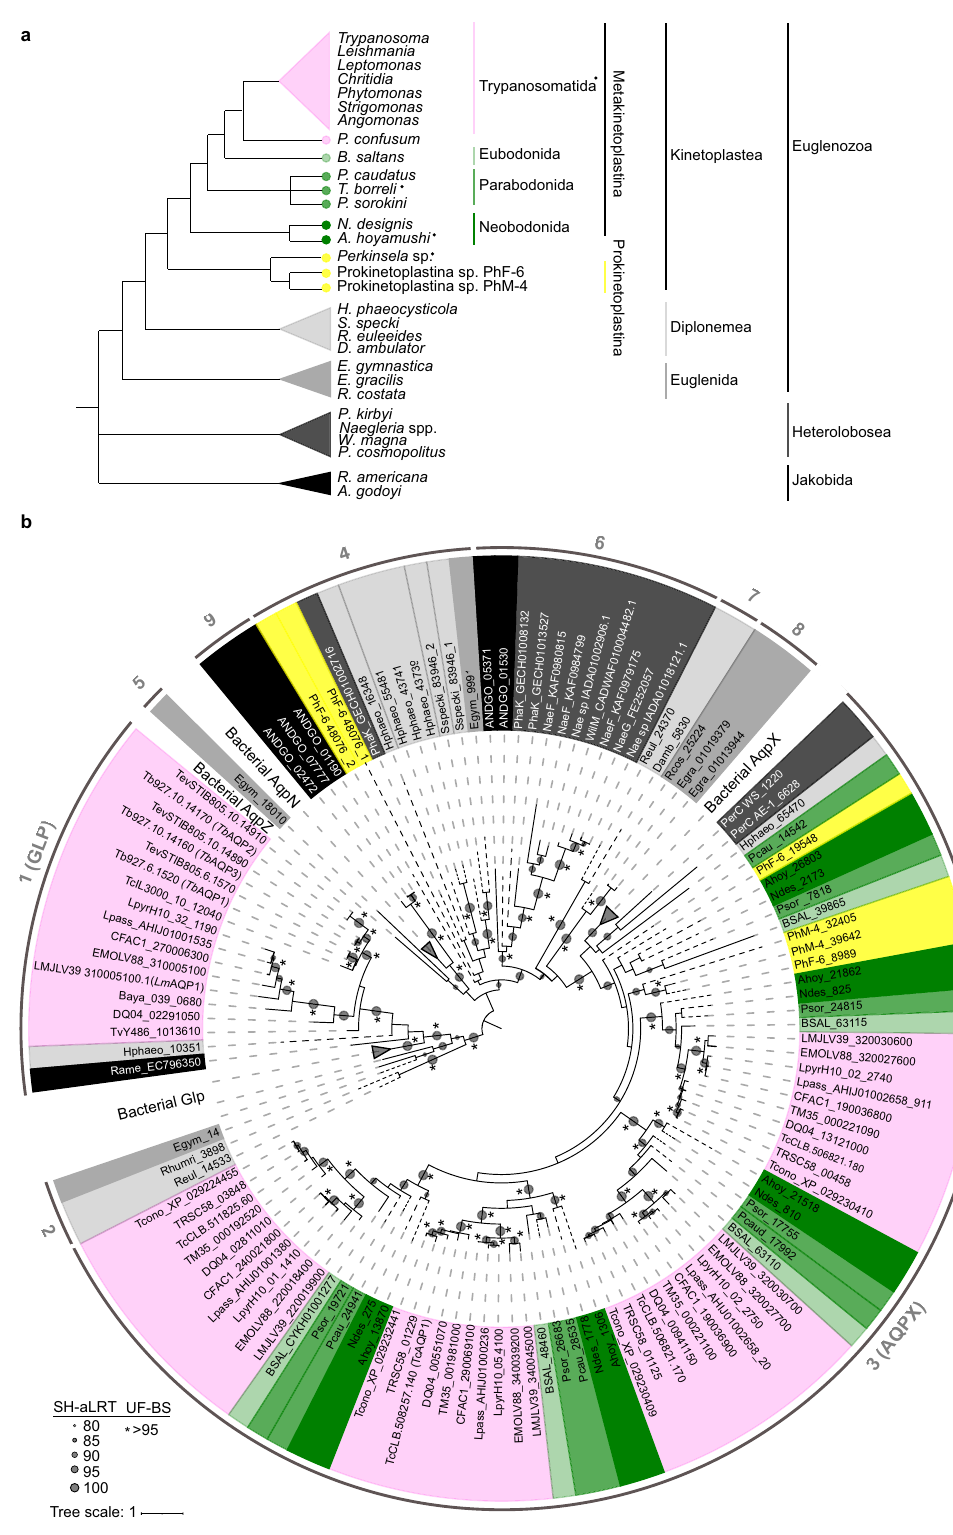
Fig. 3 Preliminary phylogenetic tree of the Discoba Major intrinsic proteins (MIPs) superfamily. a Cladogram showing the current accepted evolutionary relations inside the Discoba supergroup 36,77,78 . Genera and species present in this cladogram correspond to those with genome/transcriptome data analyzed in the current work. Parasitic species or genera are indicated by full black circles superscripts. b Discoba MIPs preliminary phylogenetic tree reconstructed by maximum likelihood. Branch support was assessed by the ultrafast bootstrap (UF) approximation with 10,000 replicates and the SH-aLRT with 1000 replicates. Accessions were shaded following the same color code of the cladogram in a . Dashed lines represent transcriptome retrieved sequences and each MIP clade is referenced by a